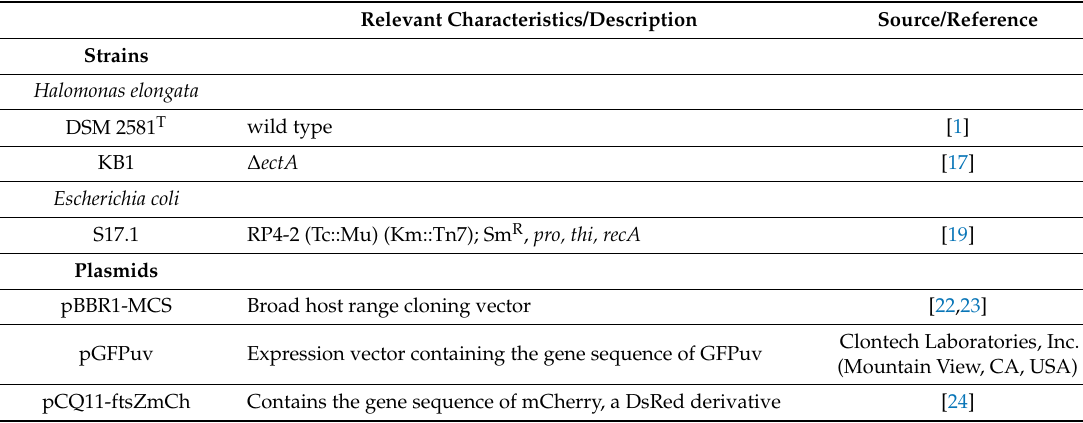
Table 1. Bacterial strains and plasmids used in this